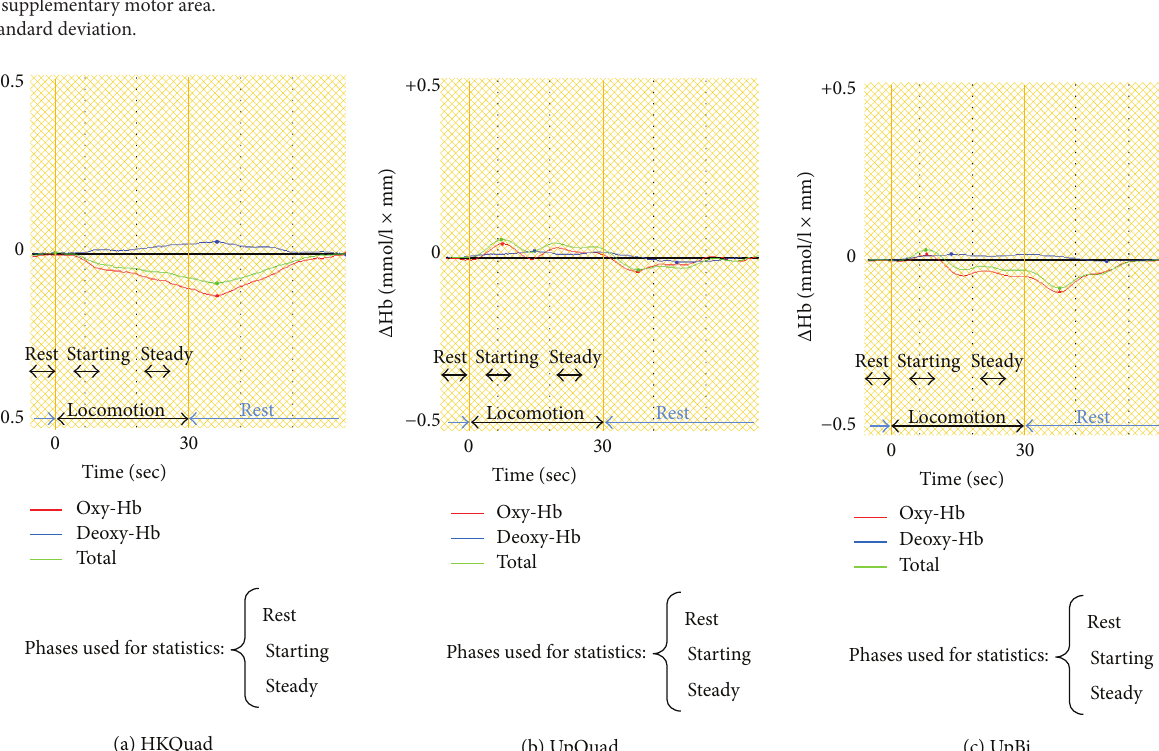
the oxy-Hb value in the starting phase was not significantly different, but the value in the steady phase was significantly lower ( 𝑝 < 0.05 , Table